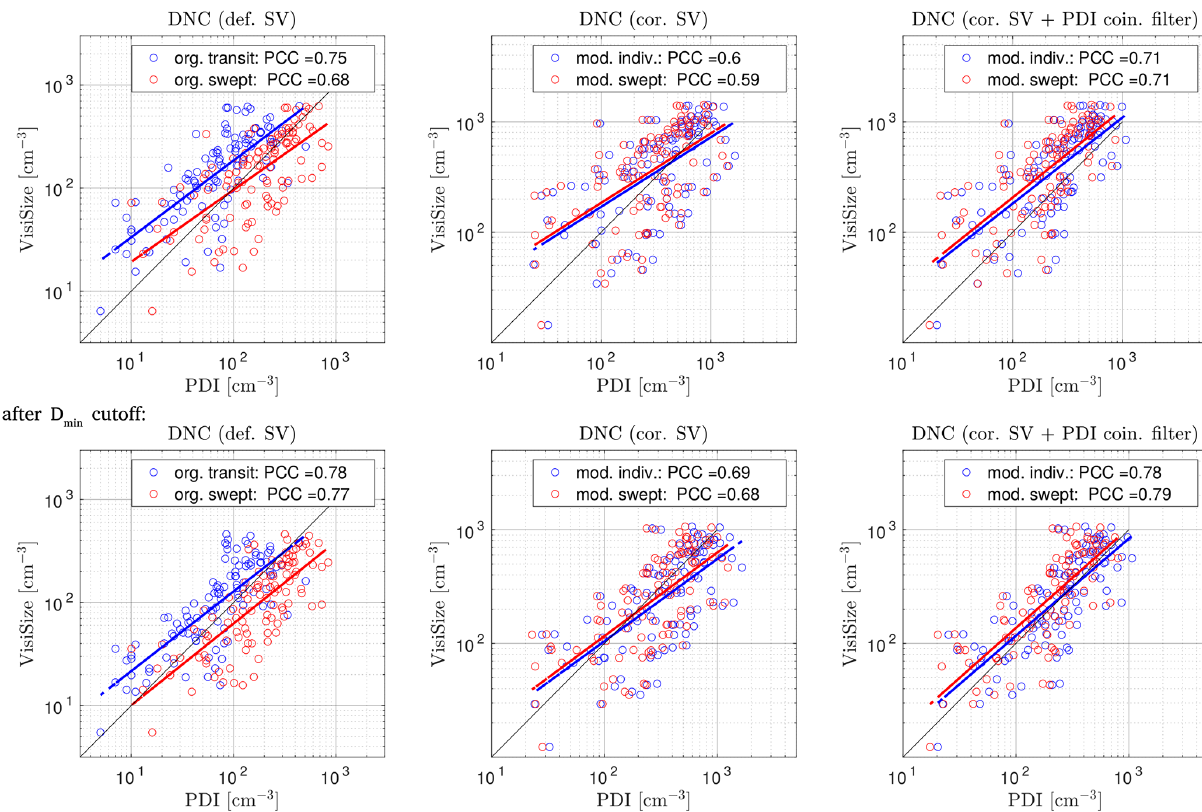
Figure 9. Comparison of the DNC results between the VisiSize and the PDI probe. From top left to top right, the plots show the raw data (based on the default sample volume for the VisiSize and the original DNC methods for the PDI), the data after modification, and the modified data after applying the coincidence filter to the PDI results. The scatter plots after applying the D min cutoff are shown in the second row. Each PDI method for the DNC computation is shown with a different color within the plots (each pair of blue and red circles: a selected measurement of ∼ 15min). Dashed blue/red lines show the LSR, and the PCCs are displayed in the